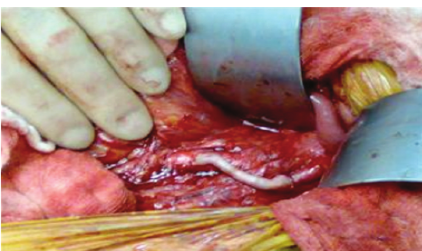
Figure 3: The right common iliac artery (RCI) and inferior mesen- teric artery (IMA) were identified and isolated. The saphenous vein was harvested from the right leg and was reversed and anastomosed end to side from the proximal right common iliac artery to the proximal inferior mesenteric